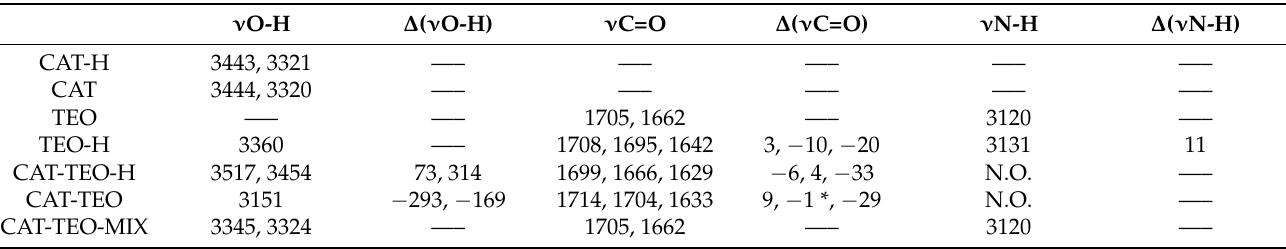
Table 1. O-H, C=O and N-H stretching frequencies (cm − 1 ) CAT-H (catechol ground with water), CAT (catechol), TEO (theophylline), TEO-H (theophylline ground with water), CAT-TEO-H (catechol and theophylline ground with water), CAT-TEO (catechol ground with dichloromethane), CAT-TEO-MIX (physical mixture of catechol and theophylline). (*) under the spectral resolution. N.O. = not